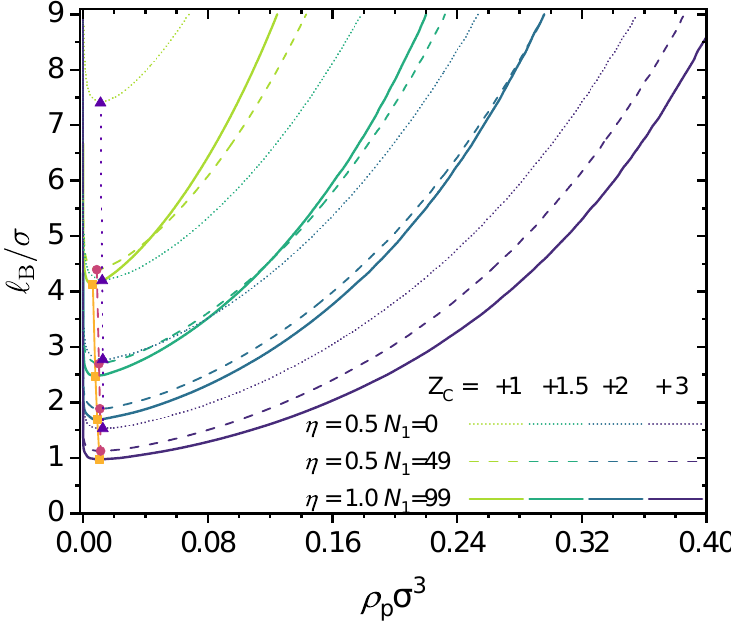
Figure 6. Predicted binodal curves from the GUI App presented in this work. The values for the following parameters were fixed: N T = 100, (cid:101) AC = (cid:101) A = (cid:101) B = 0, Z A = − 1. Values for η , N 1 and Z C were varied, as shown in the figure. Critical points are depicted by filled